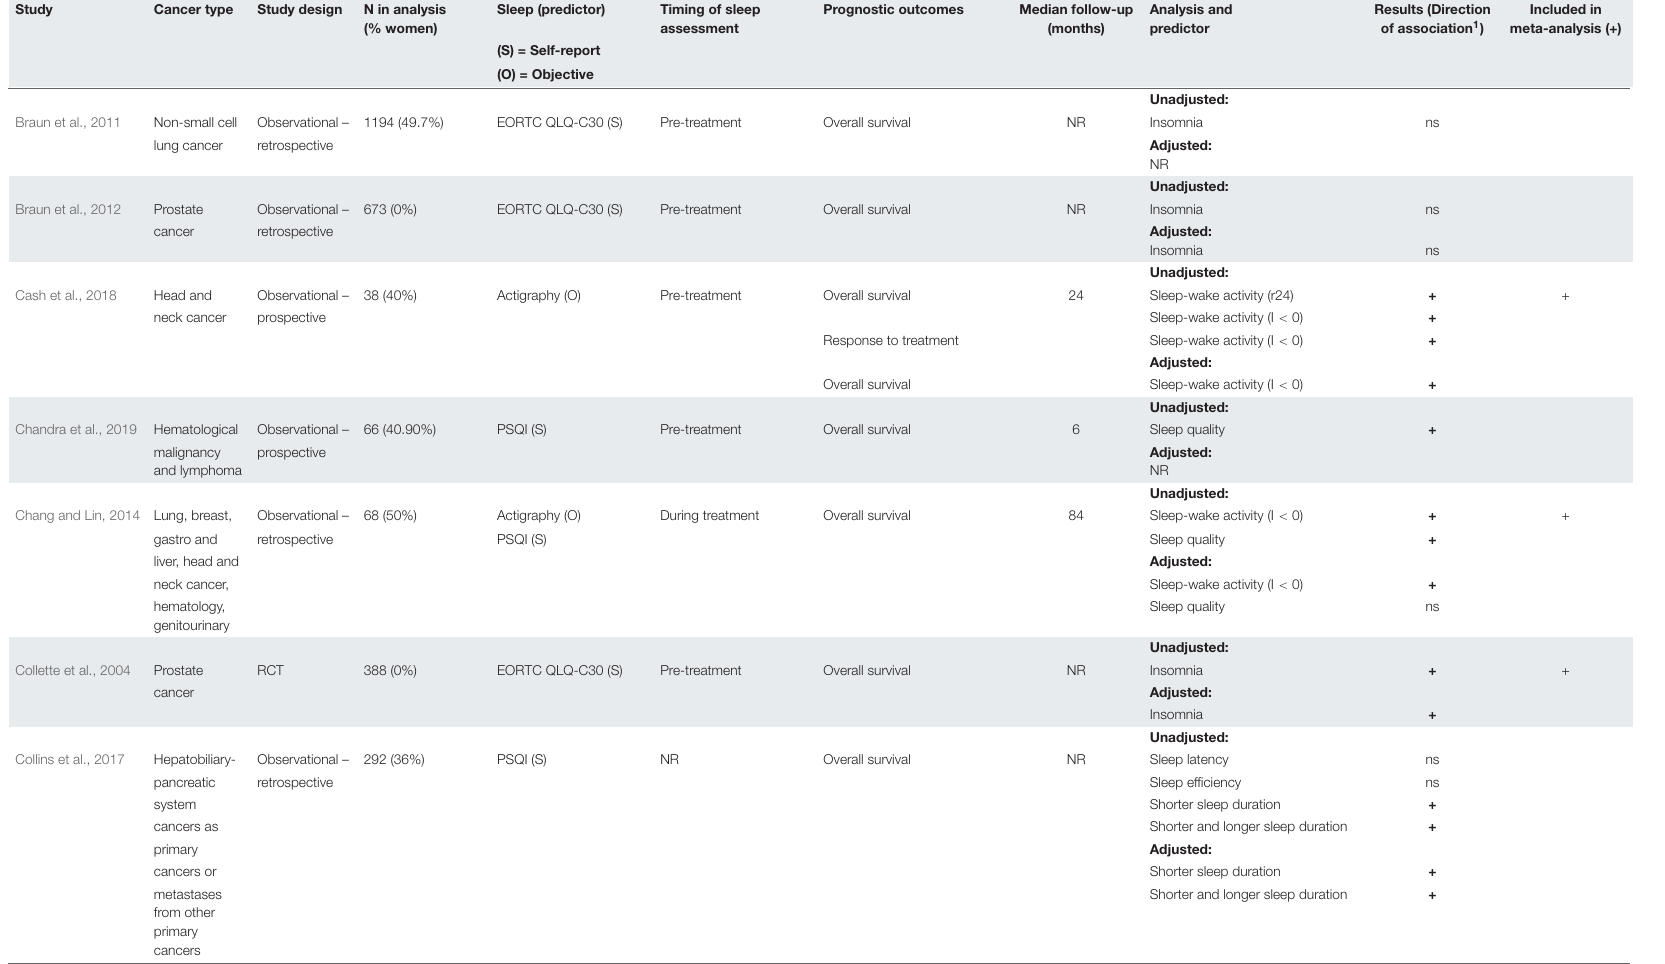
TABLE 1 | Study characteristics.